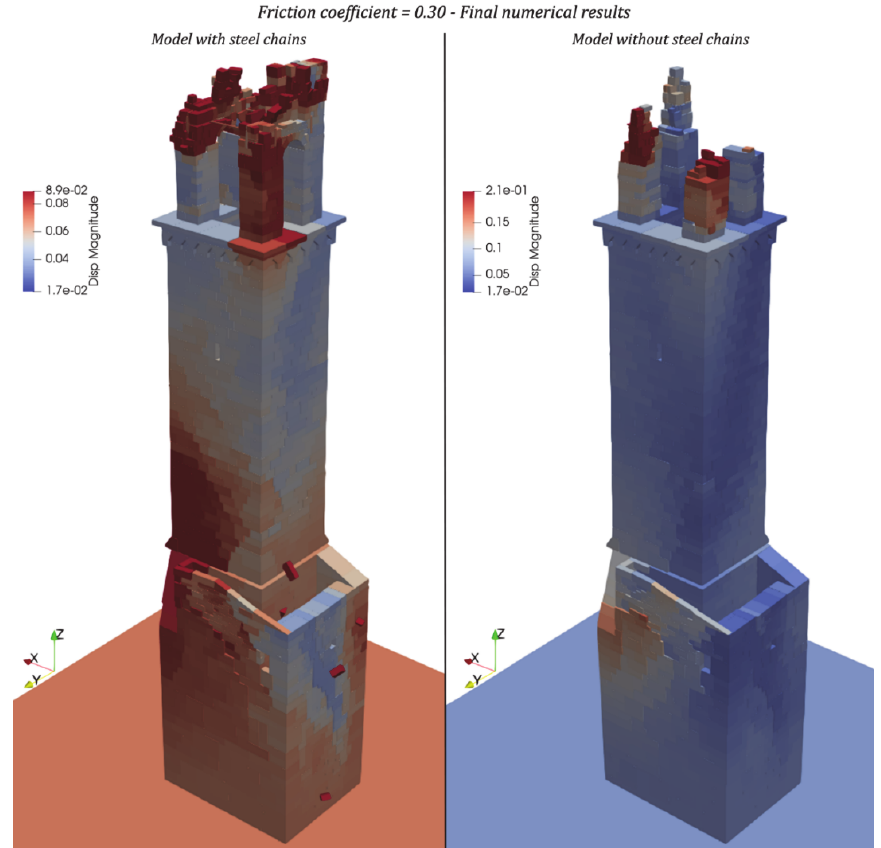
Figure 12: Numerical cumulative damages of the civic clock tower of Amatrice (Rieti, Italy) under the four main shocks recorded in the village during the Central Italy seismic sequence of 2016 for both configurations, with and without the steel chains, and with the friction coefficient equal to 0.30 in the bell cell and 0.50 in the other